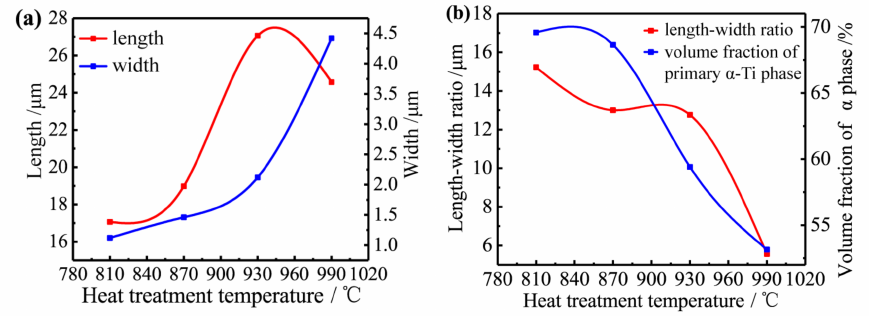
Figure 5. ( a ) E ff ect of normalizing temperature on the length and width of primary α -Ti phase, ( b ) e ff ect of normalizing temperature on the aspect ratio and volume fraction of primary α -Ti phase.